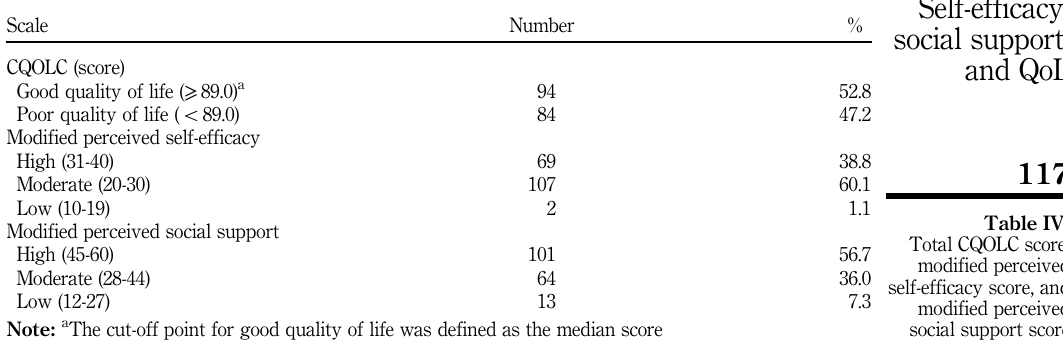
Table IV. Total CQOLC score, modified perceived self-efficacy score,